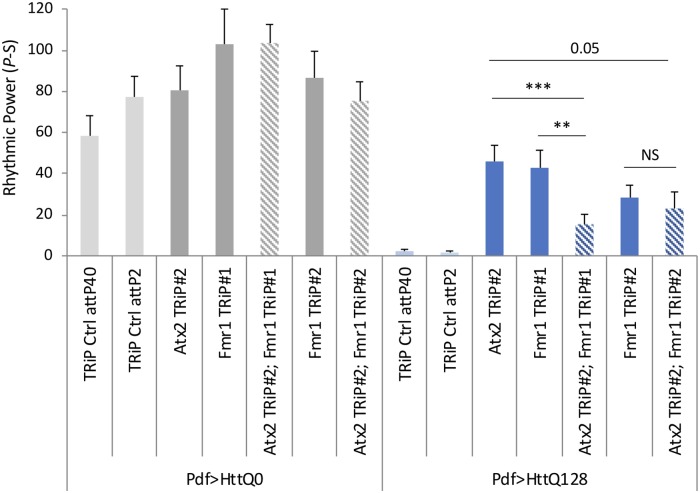
Atx2 and Fmr1 effects on HttQ128 toxicity depend on each other.Rhythmic power (P-S) is indicated for various genotypes including flies expressing HttQ0 (Pdf>HttQ0 in grey) or HttQ128 (Pdf>HttQ128 in blue) in PDF neurons in a TRiP RNAi library control background (TRiP Ctrl attP2) and expressing two independent Fmr1 TRiP RNAi lines (Fmr1TRiP #1 and #2) or expressing both Atx2 and Fmr1 RNAi together (Atx2 TRiP#2;Fmr1 TRiP #1 and Atx2 TRiP#2;Fmr1 TRiP#2; n = 10–41; *p<0.05, **p<0.01, ***:p<0.005, error bars represent standard error; n = 10–32). Some control data is reproduced from Fig 6.